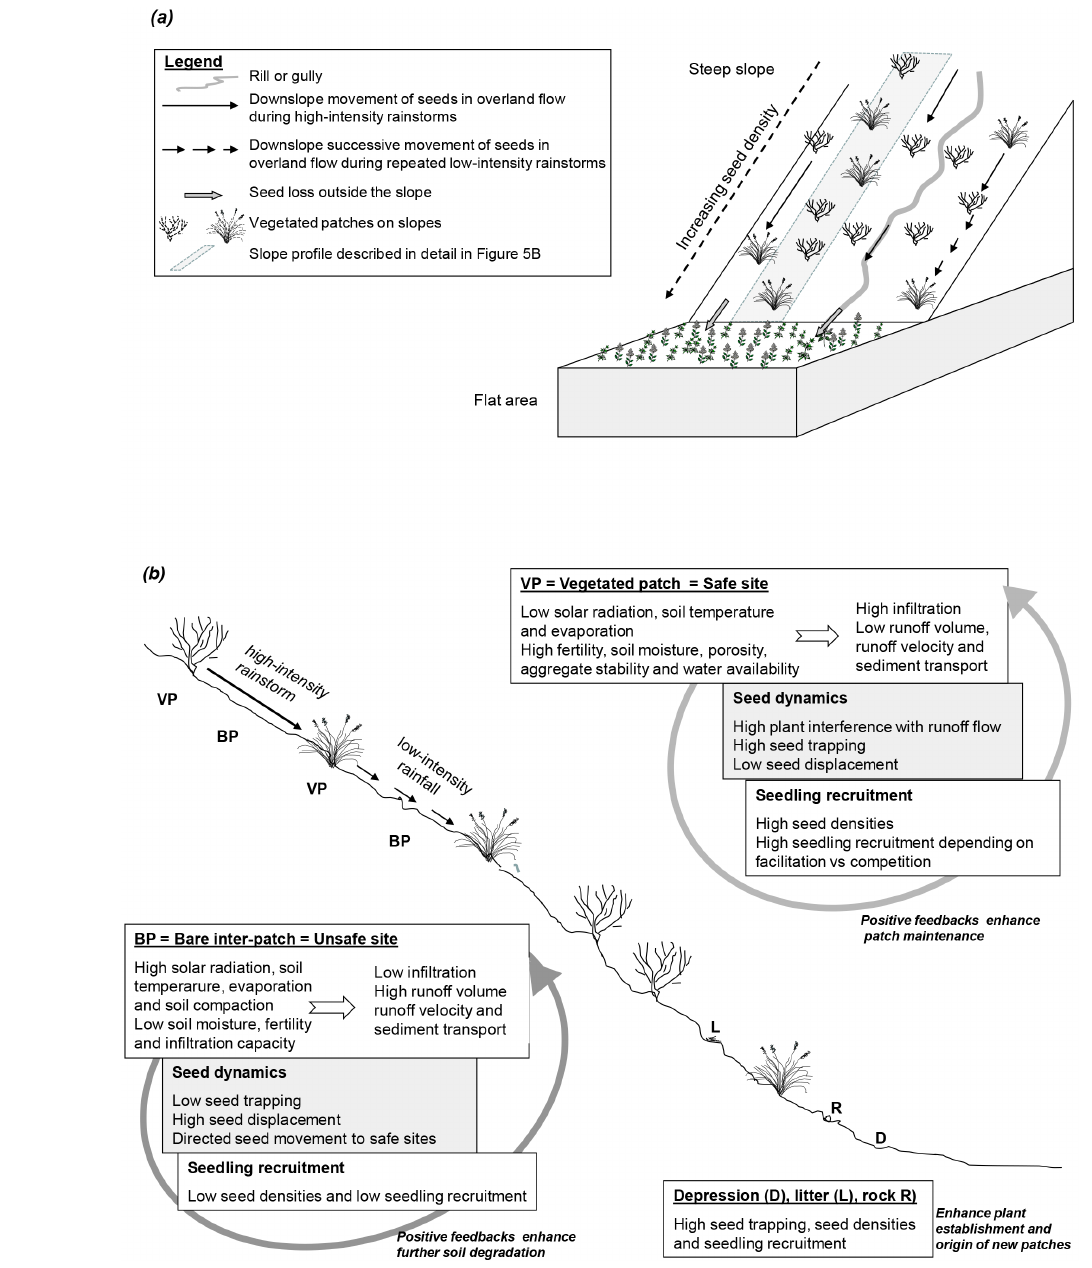
Figure 5. Schematic figure of seed fate in overland flow at the (a) slope scale and (b) patch scale (patch-to-patch transmission of seeds). The figure represents how the spatial pattern of the vegetation influences seed distribution and seed fate and how, in turn, seed fate influences the origin and maintenance of patches in arid and semiarid patchy